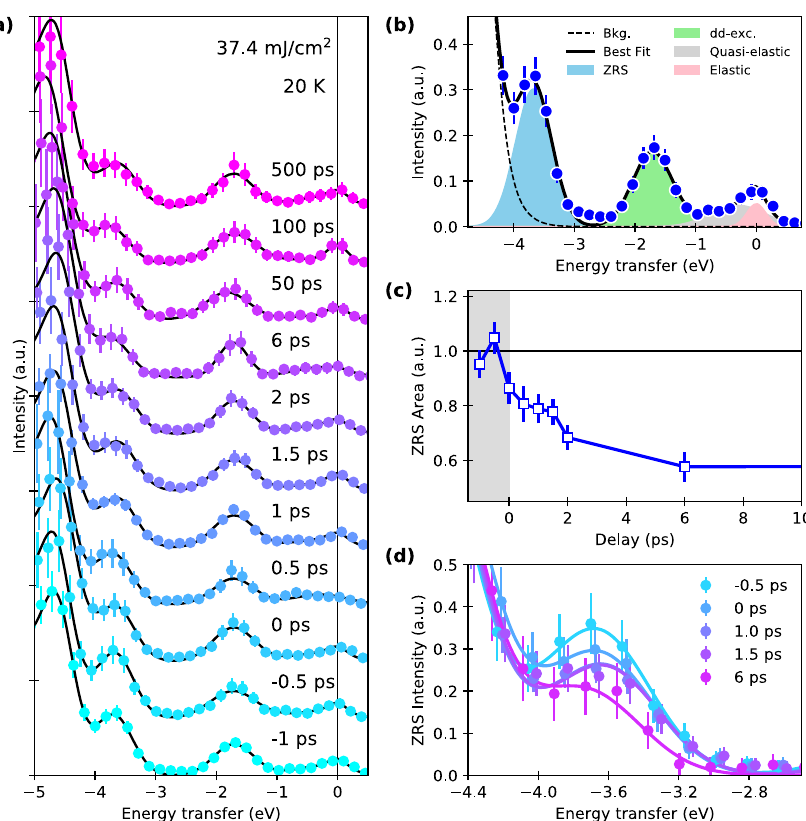
Fig. 2 Time-resolved RIXS spectra and ZRS dynamics. a O K -edge RIXS spectra (markers) collected with a pump fl uence of 37.4 mJ cm − 2 . Spectra taken at different pump-probe delays are shown with a vertical offset. The black line represents the best fi t curve. The error bars are obtained by analyzing the fl uctuation between different acquisitions taken under the same conditions. b Example of the multicomponent fi t procedure used to extract the intensity of the ZRS excitation. The different components (denoted in the legend) are modeled with Gaussian functions. c Evolution of the integrated intensity of the ZRS excitation as a function of the pump – probe delay. The error bars represent the con fi dence interval obtained from the fi t. d O K -edge RIXS spectrum around the ZRS excitation for selected time-delays as indicated in the